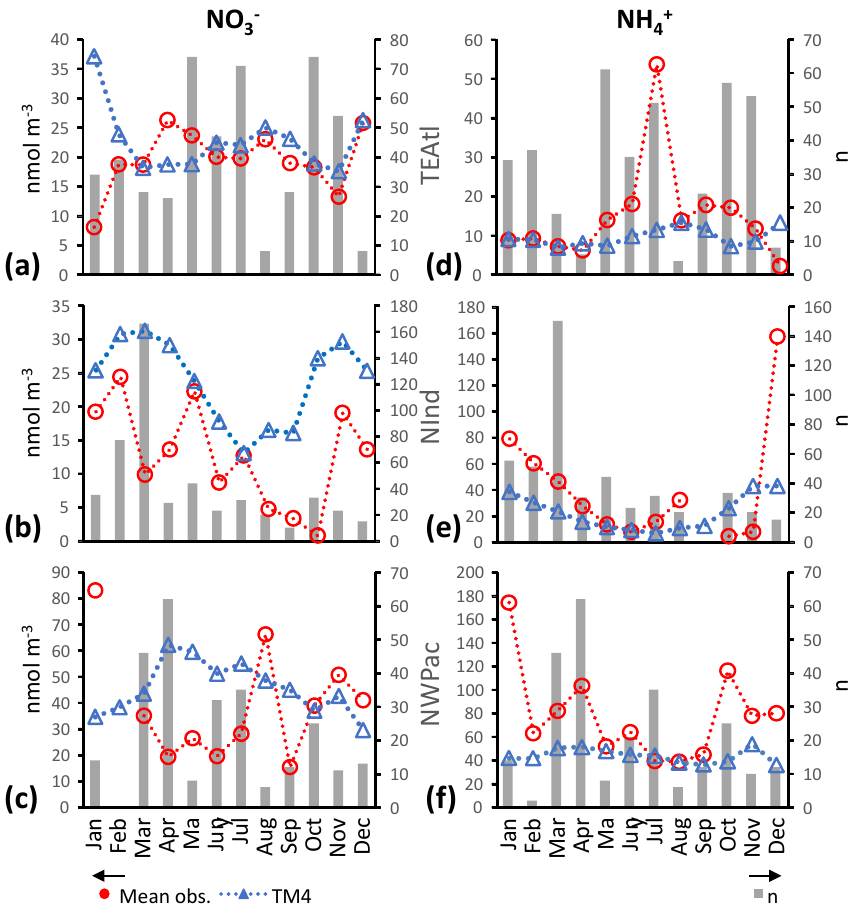
Figure 14. Monthly mean observed aerosol concentrations (red circles), simulated concentrations from TM4 (blue triangles) and total number of observations in each month (bars) for NO − (left) and NH + (right) for the TEAtl (a, d) , NInd (b, e) and NWPac (c, f) 3 4